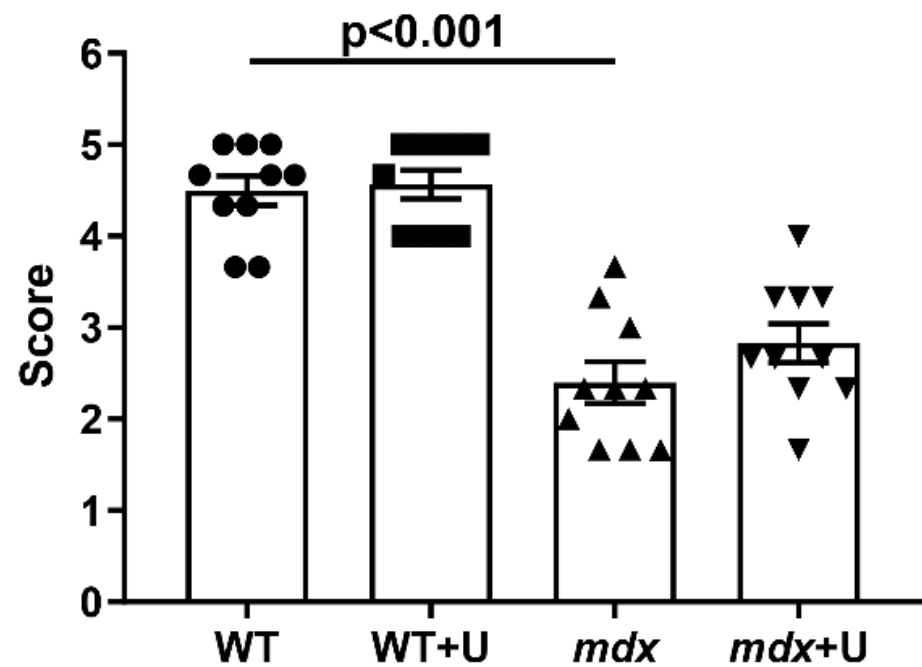
Figure 2. The results of a wire hanging test, reflecting the effect of uridine administration on muscle function and endurance in the studied groups of mice. The data are presented as means ± SEM ( n = 10).